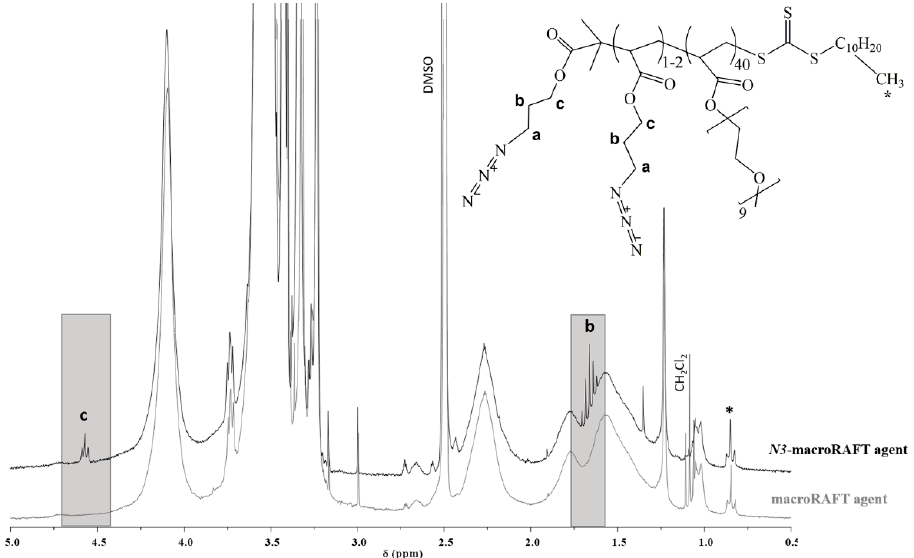
Figure 1. 1 H-NMR spectra of P(AA 2 - co -PEGA 40 )-TTC before and after functionalization with the azide moiety. ( inset ) Chemical structure of the N3 -macroRAFT agent. PEGA: poly(ethylene glycol) methyl